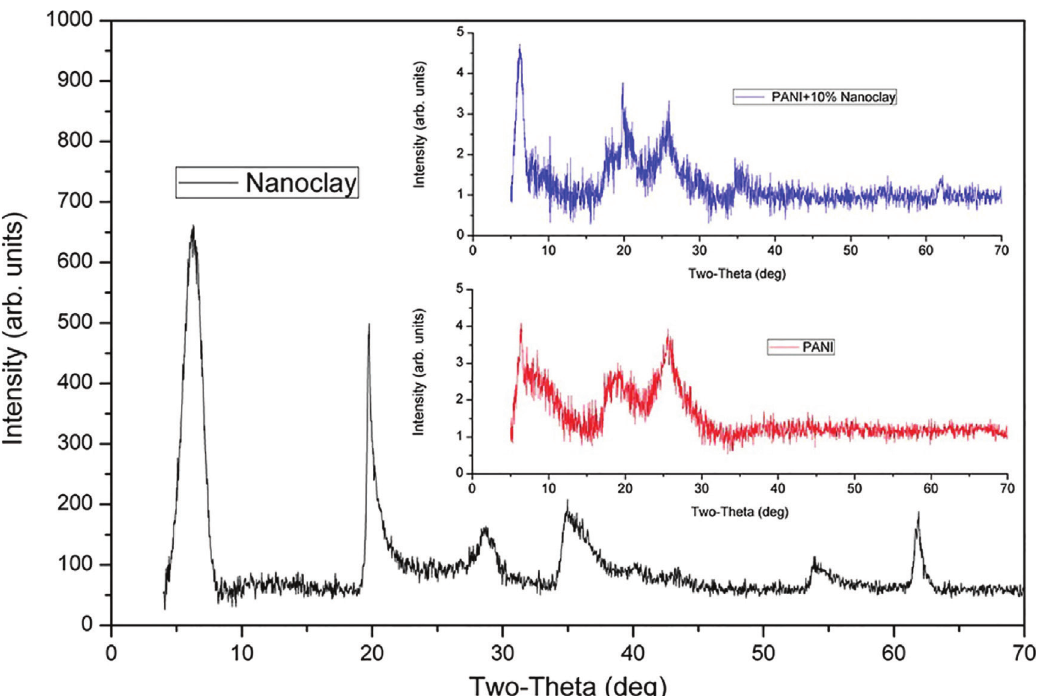
Fig. 2: X-ray diffraction patterns of NanoClay(NC), PANI and PANI +